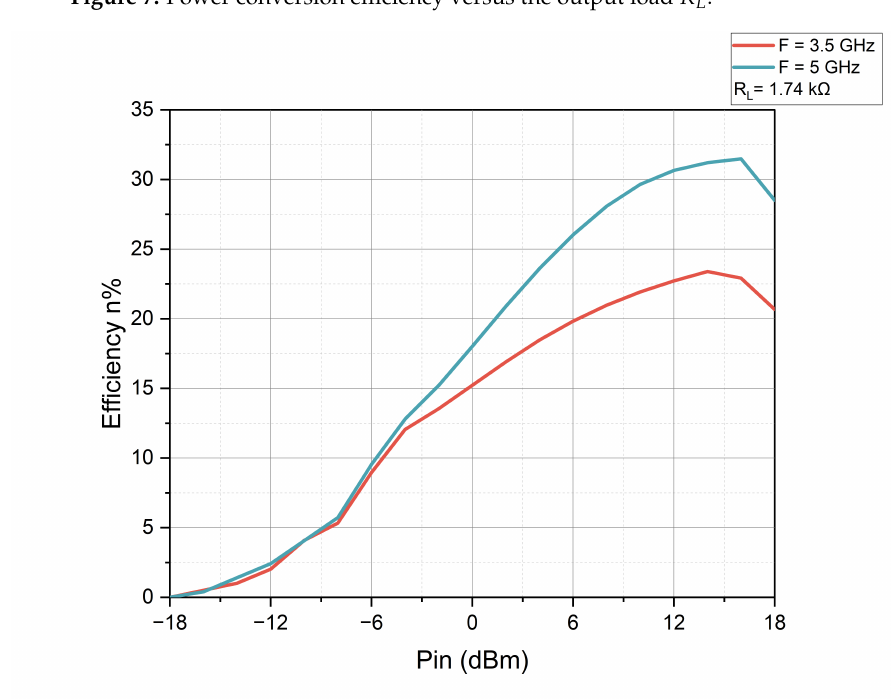
Figure 8. Power conversion efficiency versus input power P i n